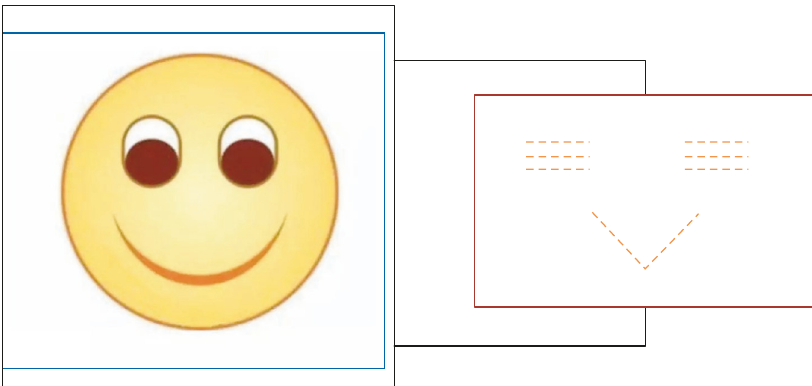
Figure 1: Key data extraction of expression package.